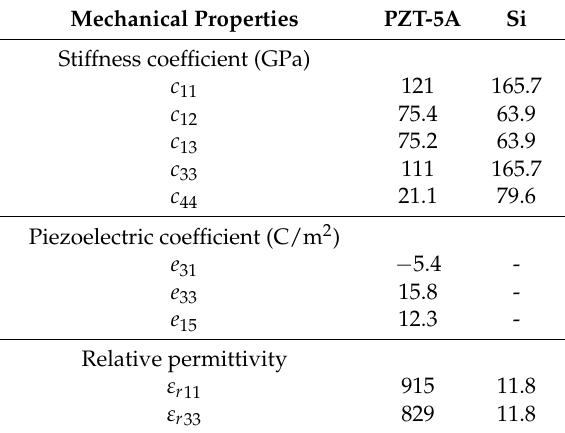
Table 2. Fundamental properties of P-5A [35] and silicon materials in this simulation. Mechanical